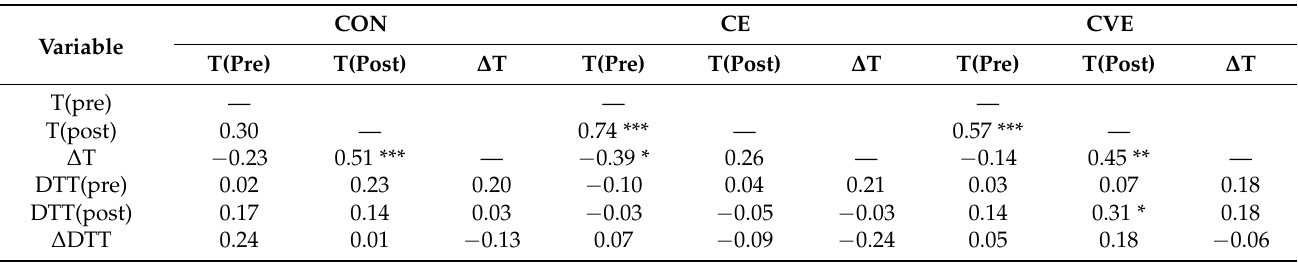
Table 5. Spearman’s correlation coefficients for pre-, post-test, difference values (delta) of testosterone concentration, and fine motor skills in the two experimental groups (CE and CVE) and the control group (CON).